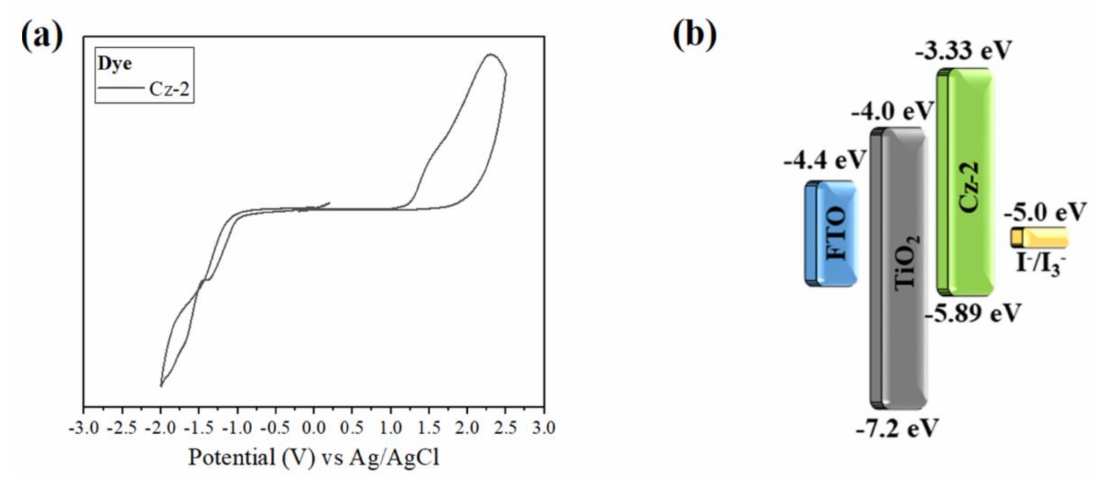
Figure 4. ( a ) Cyclic voltammogram of Cz-2 dye in the film form, ( b ) schematic representation of the energy levels of dye-sensitized solar cell (DSSC) components. Table 1. Eg, opt., oxidation onset potential, highest occupied molecular orbital (HOMO), and lowest unoccupied molecular orbital (LUMO) energy levels of the Cz-2 dye in film form on fluorine-doped tin oxide (FTO) glass.